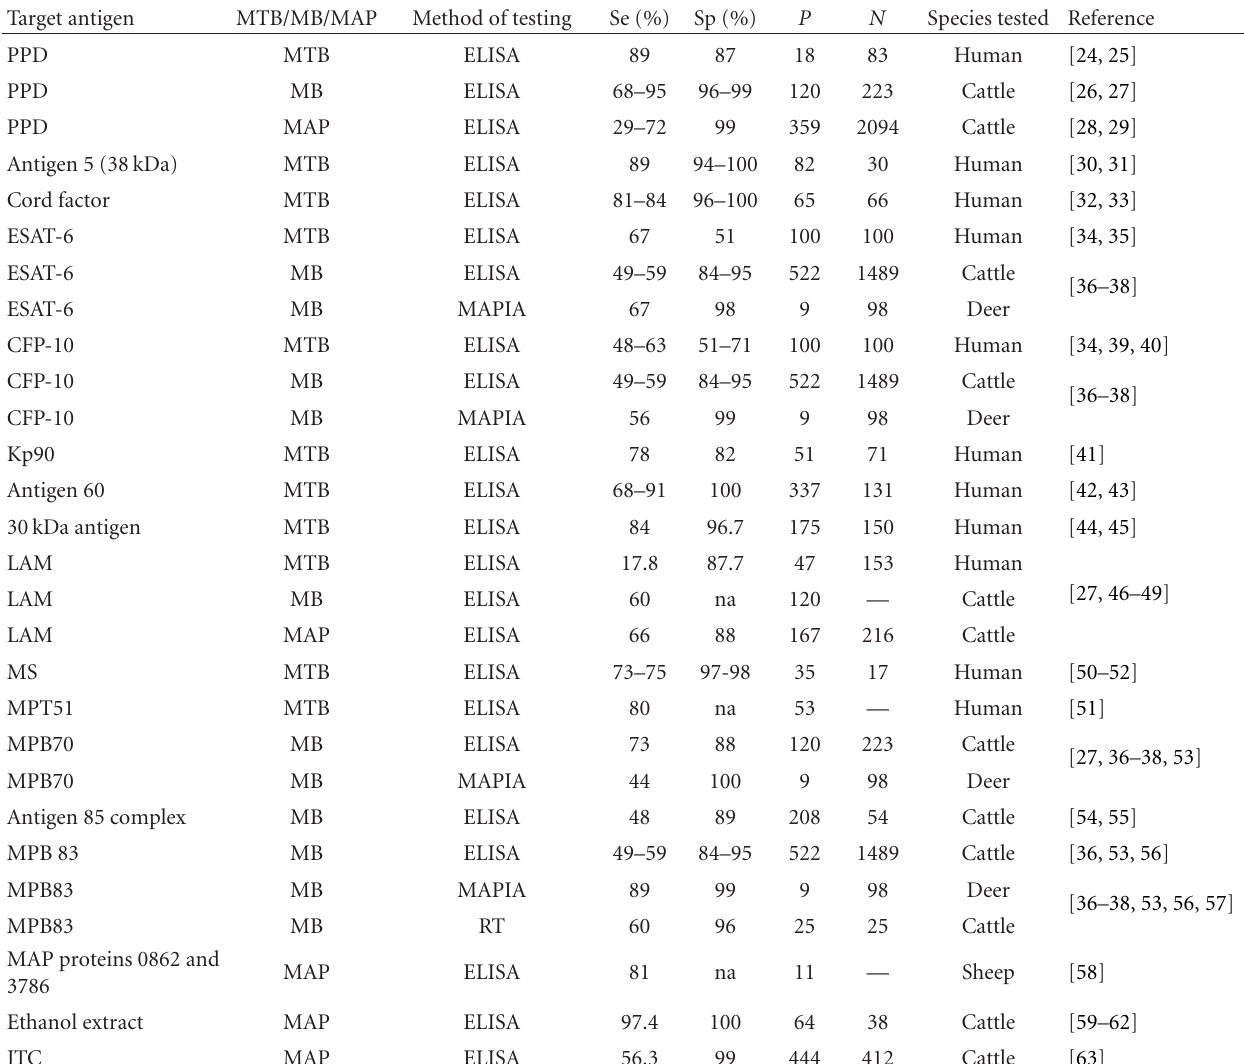
Table 1: Summary of humoral immune response based